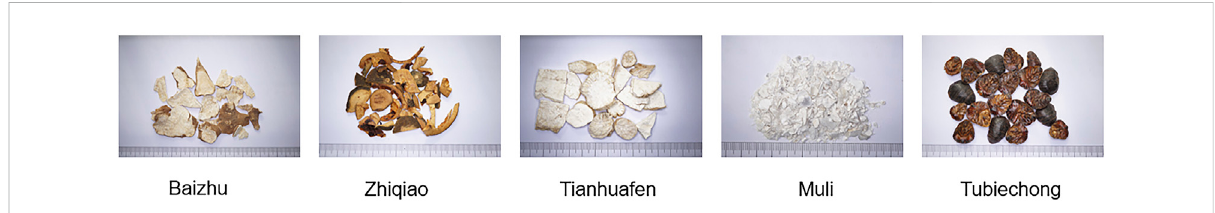
FIGURE 1 Photographs of Atractylodes Macrocephala Koidz. (Baizhu), Citrus aurantium L. (Zhiqiao), Trichosanthes kirilowii Maxim. (Tianhuafen), Ostreae Concha (Muli) and Eupolyphaga sinensis Walker (Tubiechong) in medicinal ingredient